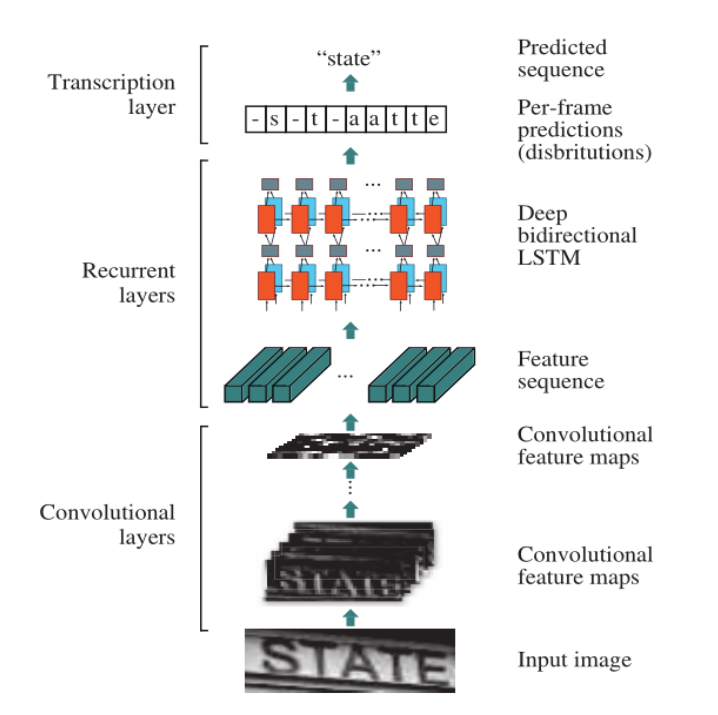
Figure 9. The framework of CNN + LSTM +